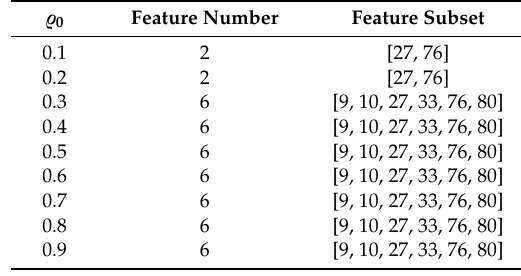
Table 4. Features acquired on the TCP flow dataset when (cid:37) 0 values are di ff erent.